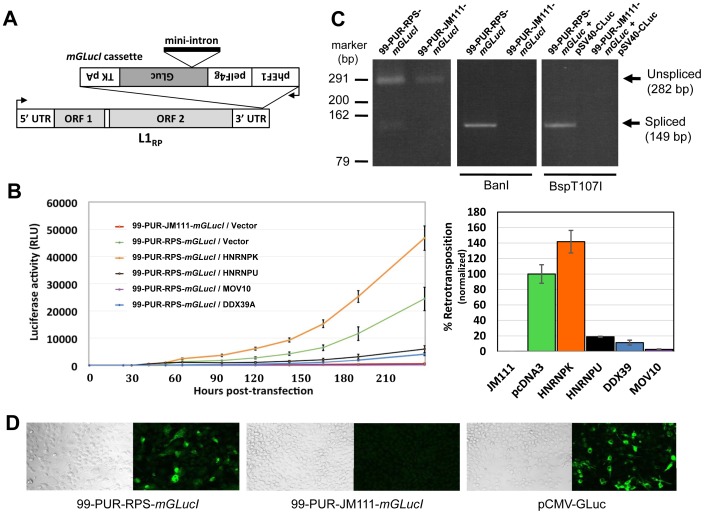
A novel secreted Gaussia luciferase L1 retrotransposition assay system.(A) A novel Gaussia luciferase cassette in a human L1. The mGLucI retrotransposition cassette was cloned into the 3′ UTR of L1RP in the antisense orientation. The cassette contains the GLuc gene interrupted by an antisense mini-intron with an EF-1α/eIF4g hybrid promoter (phEF1/peIF4g) and the TK poly(A) signal (TK pA). GLuc can be expressed only when retrotransposition occurs. (B) Coexpression in HEK293T cells of selected cDNA constructs, previously determined to alter retrotransposition levels in the EGFP reporter assay (right panel; [40]), similarly affect retrotransposition in the GLuc assay (left panel). Fifty µl of media were sampled from each well (four replicate wells for each construct) at the indicated hourly time points over the course of 10 days and tested at the conclusion of the experiment (RLU: Relative Light Units). EGFP assays were performed at approximately 115 hours and results were normalized to cotransfected 99-PUR-RPS-EGFP reporter construct and empty vector (pcDNA3). Data for the earliest time-points sampled are reproduced in Fig. S3. (C) Retrotransposition in HeLa cells is confirmed by PCR using primers that flank the intron of the GLuc reporter gene. The presence of a band of 149 bp is diagnostic for intron removal. A 283-bp band is amplified from the transfected 99-PUR-RPS-mGLucI or 99-PUR-JM111-mGLucI plasmid. (D) Immunofluorescence analysis of transfected and fixed HEK293T cells showing obvious expression of GLuc from retrotransposition events formed by 99-PUR-RPS-mGLucI but not 99-PUR-JM111-mGLucI. Constitutive luciferase expression from pCMV-GLuc is also shown (right), detected by α-Gaussia antibody.